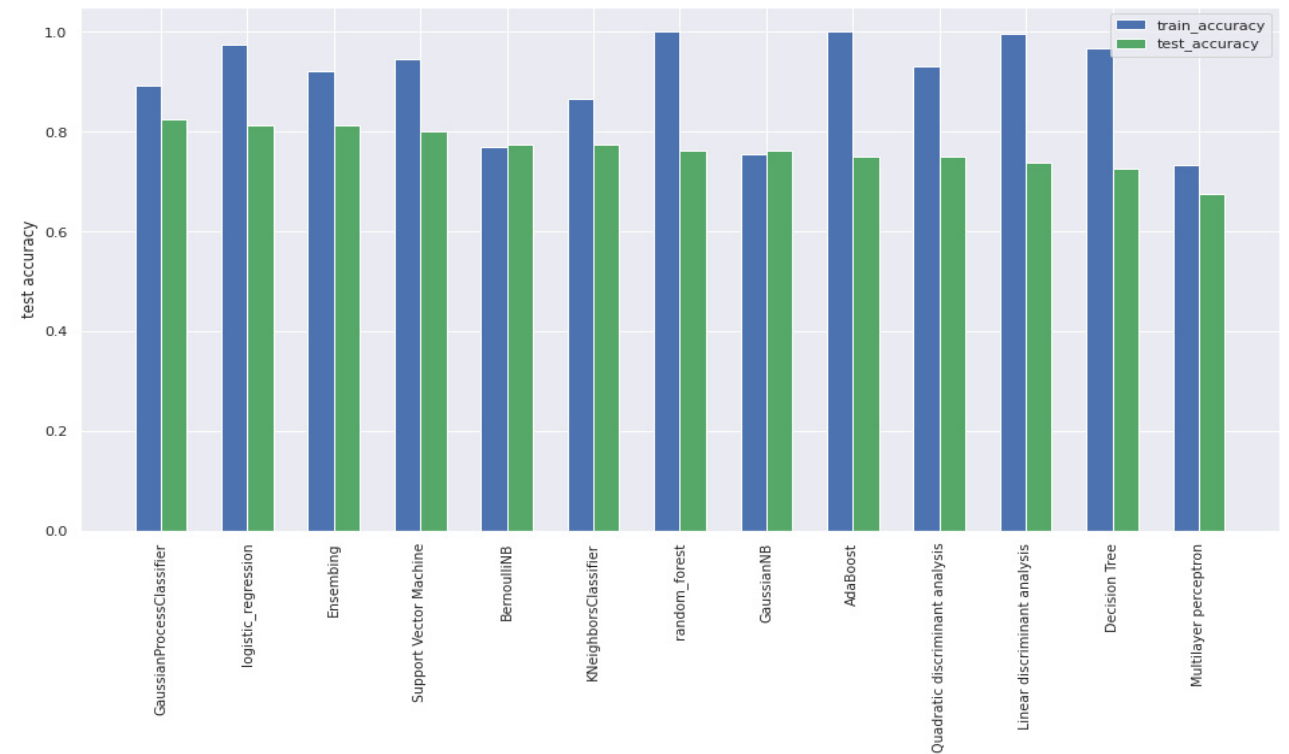
Figure A5. Pair plot of all the score of the analysis 1—Remobi Alouette reading dataset.